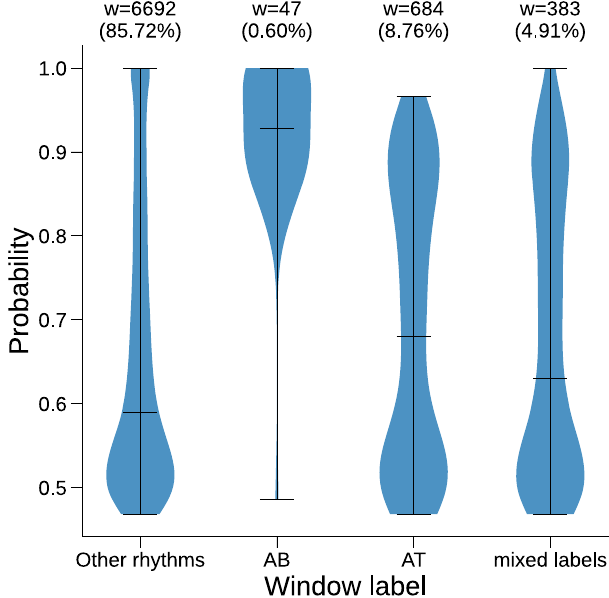
Fig. 4 Histogram of the ArNet2 estimated AFB (AF Burden) for the RBDB-test2. The RBDB-test2 dataset ( n = 1825) simulating the intended use scenario. The red dashed line is drawn at AFB = 4%. Table 3. Performance measures of ArNet2 for the intended use scenario and across sex and ages at the patient level.